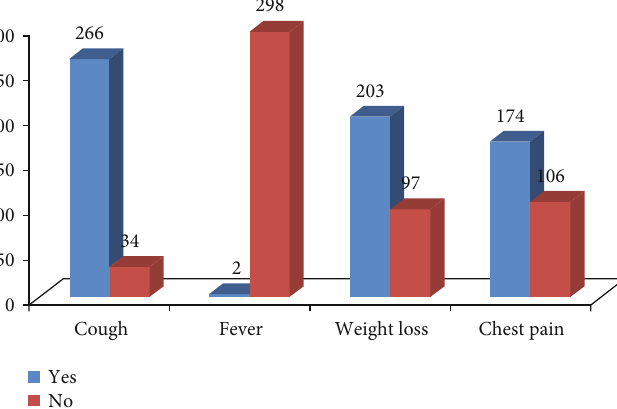
Figure 1: A graph showing clinical presentations of TB patients during onset of illness, Debremarkos Health facilities,